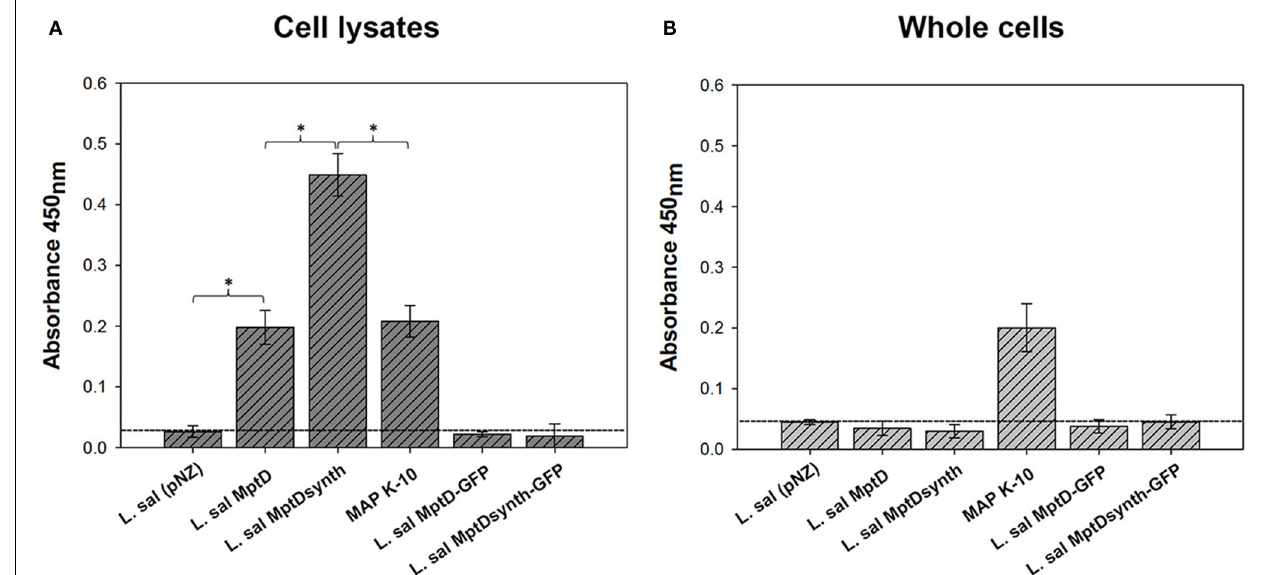
FIGURE 2 | Comparative fMptD-mediated ELISA analysis of recombinant L. salivarius cell lysate and whole-cell against MAP K-10 (A,B). Standard deviation of triplicate results is indicated by error